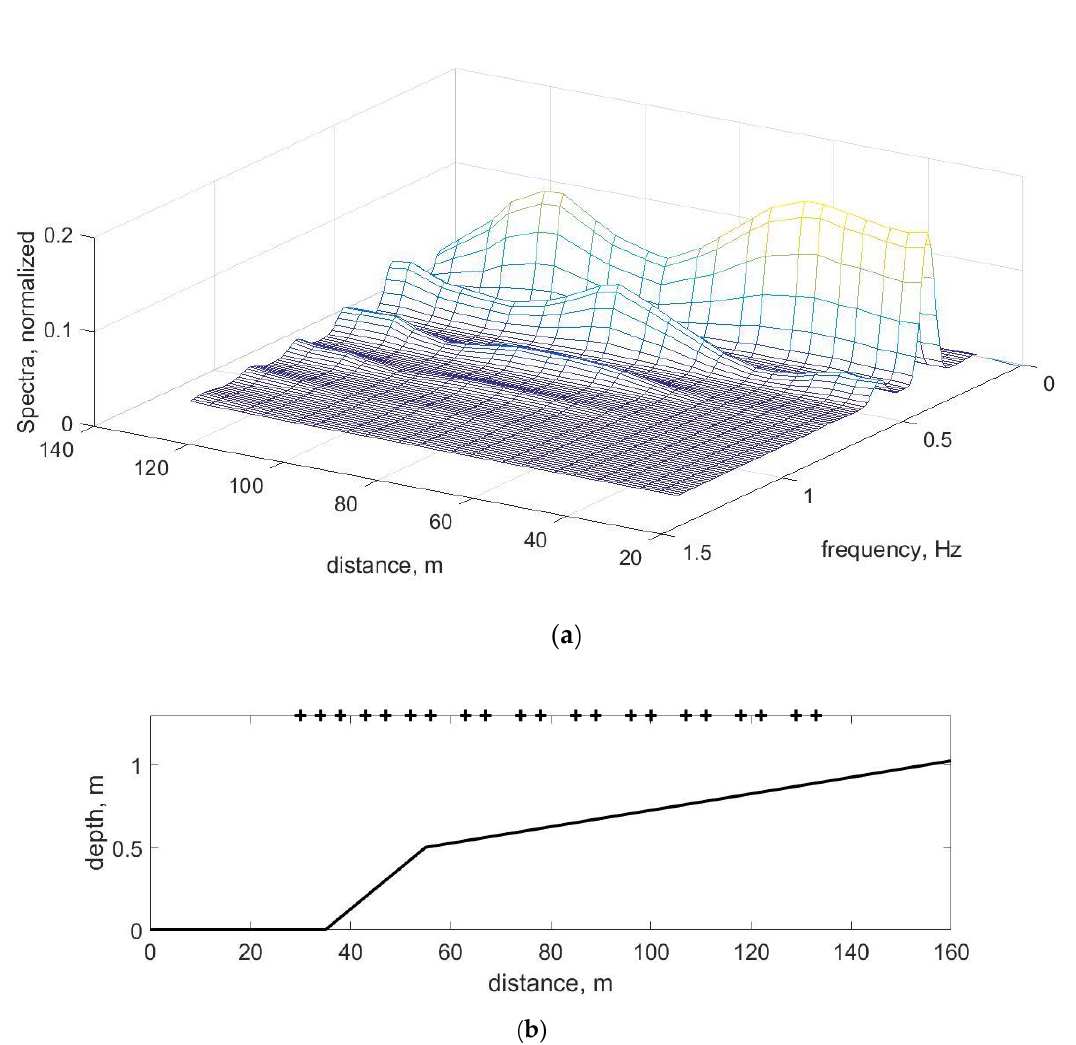
Figure 2. Periodical in-space fluctuations of wave frequency spectrum normalized on wave dispersion ( a ) over the bottom profile ( b ). Fiel Laboratory experiment Tainan 2015, series 41, + — positions of wave gauges.